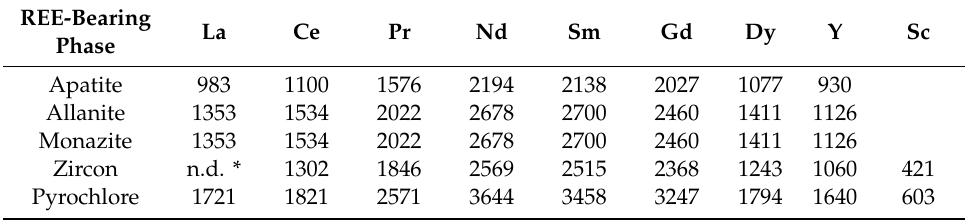
Table 3. The limits of detection (LODs) of the EPMA for REEs with samples of ore and apatite concentrate (mg /